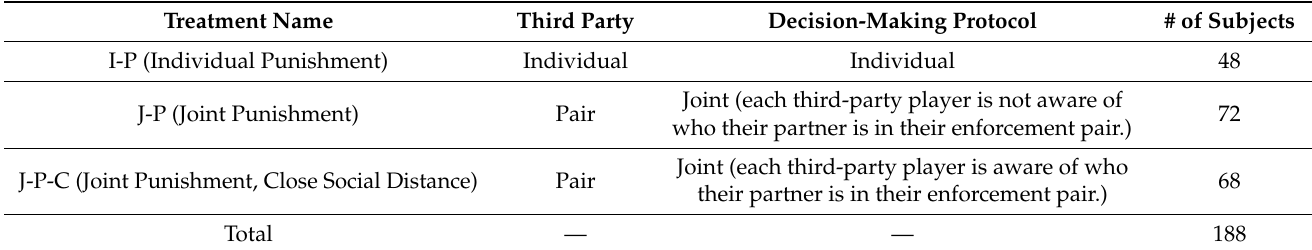
Table 1. Summary of